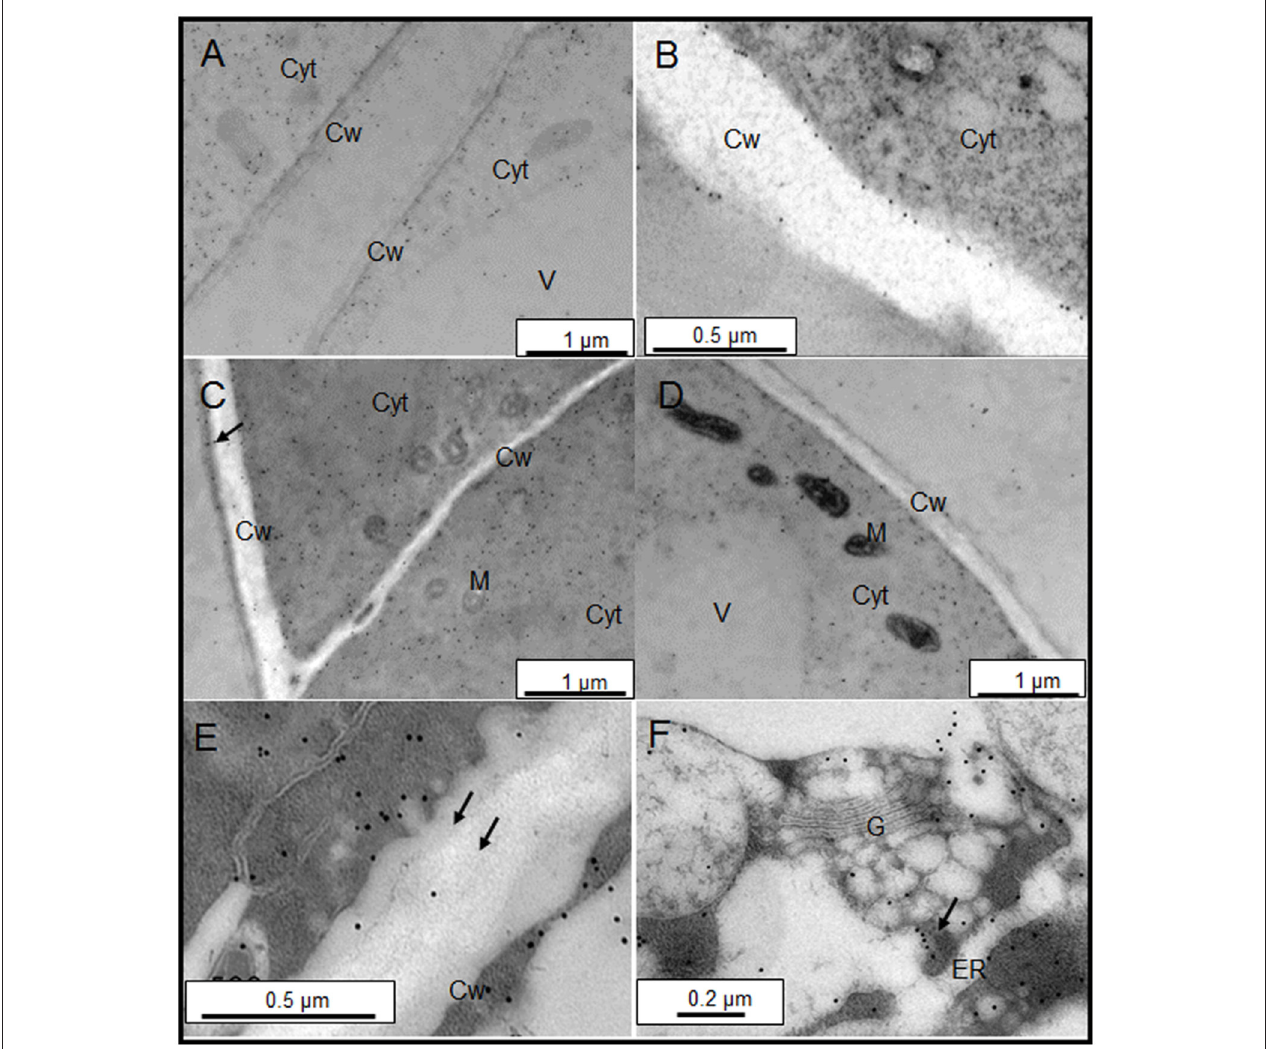
FIGURE 2 | Immunogold labeling of JIM13 AGP epitope on samples of control (A,B) and salt-adapted (C–F) tobacco BY-2cells. (A) Control cells showing abundant labeling in the cytoplasm. (B) Detail of cell wall showing a high labeling at the plasma membrane and tonoplast. (C) Salt-adapted cells showing labeling in the cytoplasm and the extracellular matrix (arrow). (D) Salt-adapted cells showing labeling in the cytoplasm. (E) Detail of vesicles showing a high labeling close to the plasma membrane (arrows). (F) High labeling of JIM13 epitope in the endomembrane system. Cyt, Cytoplasm; Cw, Cell Wall; G, Golgi, ER, endoplasmic reticulum; M, Mitochondria; V,